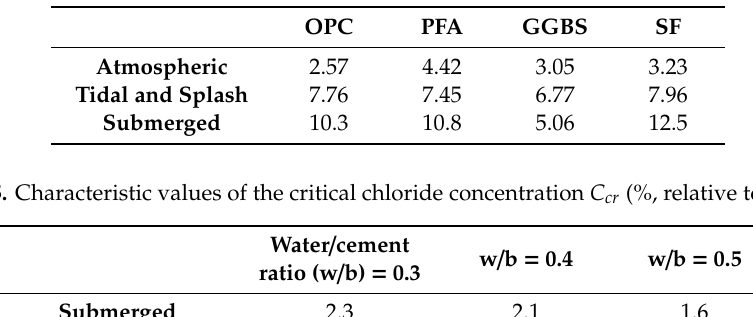
Table 4. Characteristic values of the regression parameter A C